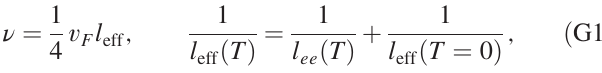
FIG. 6. (a) The scattering probability at the Fermi surface, ¼ E Þ , and (b) the dimensionless inverse viscosity P ð ϵ k F h P i ¼ ℏ = ð 2 m (cid:2) ν Þ , and, equivalently, h P i ¼ 2 = ð k Þ , as a func- l F ee tion of normalized temperature T=T for different values of ffiffiffi p F ¼ κ = ð 2 Þ in the three different k interaction parameter r s F approximations in Eq. (G2), namely, contact interaction, RPA, and HA. As r decreases, the trend RPA → HA is clearly visible. s At low temperatures, only the Fermi surface contributes to the → v τ average; hence, h P i → P or l ee F ee